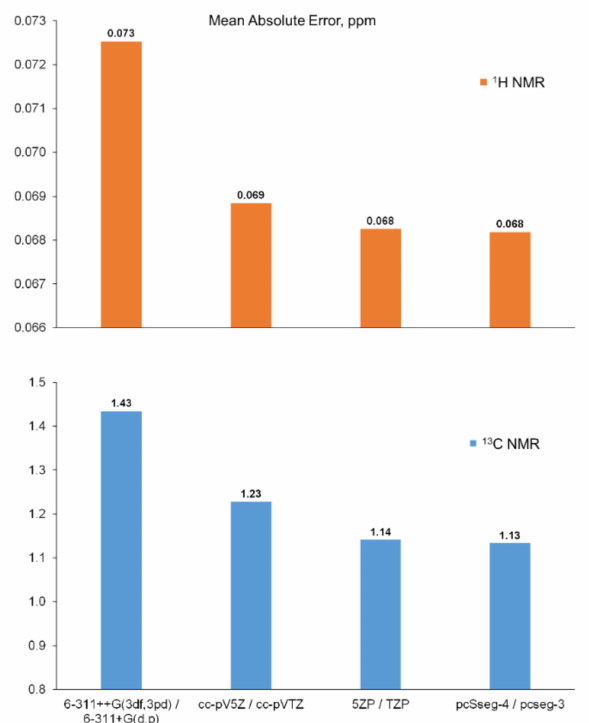
Figure 6. Mean absolute errors of 1 H-NMR ( top ) and 13 C-NMR ( bottom ) chemical shifts of strych- nine ( 2 ) calculated with using the most extended locally dense basis set schemes, as compared to experiment. Reproduced from Semenov and Krivdin [67] with the permission of John Wiley and